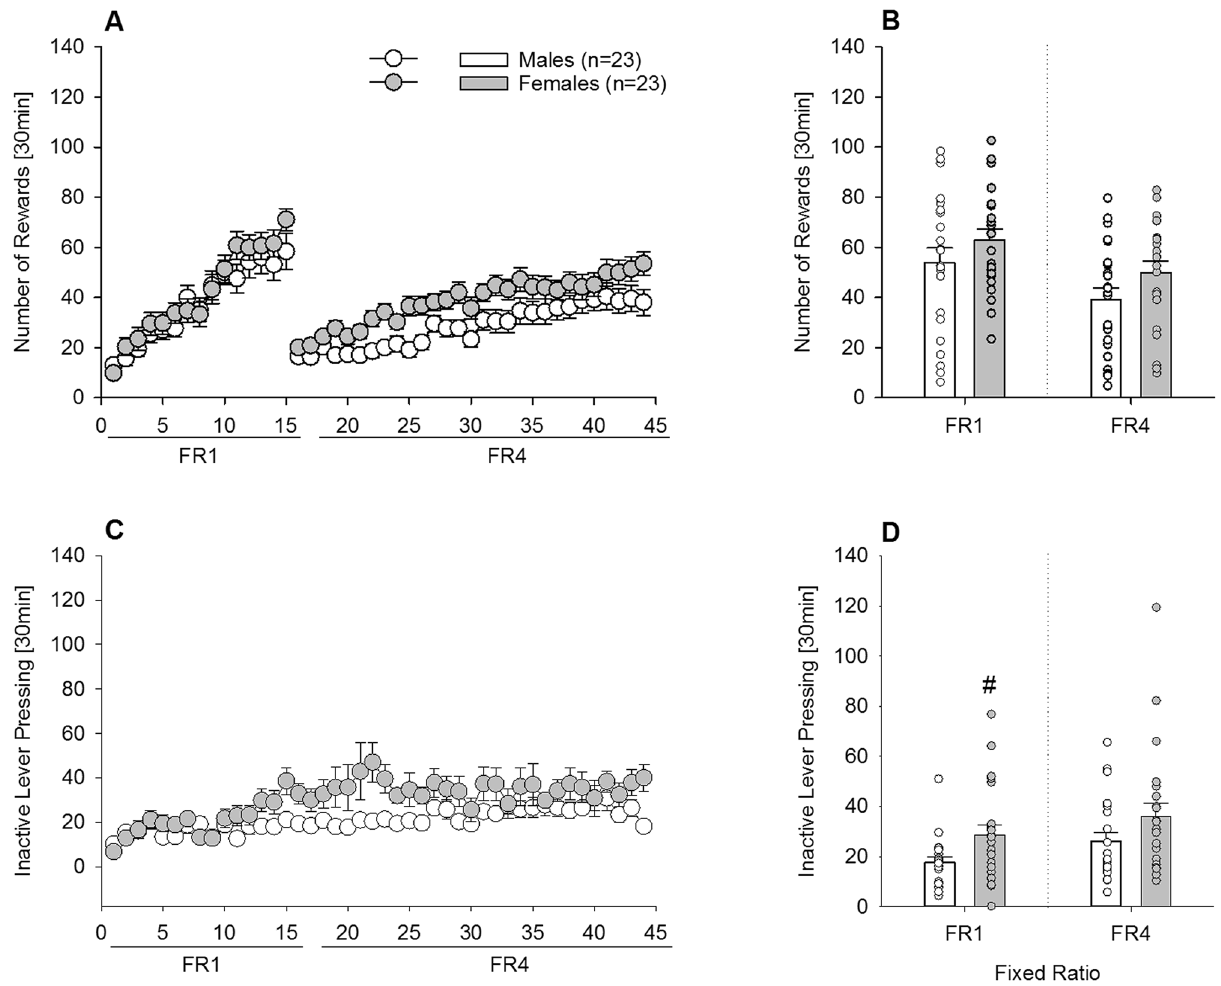
Figure 6. Long-term operant self-administration for sugar in male (n = 23) and female (n = 23) mice (Experiment 3a). ( A ) Number of rewards earned, ( C ) inactive lever pressing per sessions, during FR1 (15 sessions) and FR4 (29 sessions) schedule of reinforcement. Mean from the last 5 sessions of ( B ) rewards earned, and ( D ) inactive lever pressing in males (white circles/bars) and females (grey circles/bars). ( A ) During the FR1 phase, all mice similarly acquired and maintained stable active lever pressing for sugar and ( B ) the mean from the last 5 sessions did not differ between male and female mice. ( C ) Inactive lever pressing was higher in female mice across the 15 FR1 sessions, and ( D ) the mean of the last 5 sessions showed a significant increase compared to male mice. During the FR4 phase, ( A ) females earned more rewards and made more responses on the inactive lever ( C , D ). All data represent mean ± SEM. # indicates P < 0.05 versus male